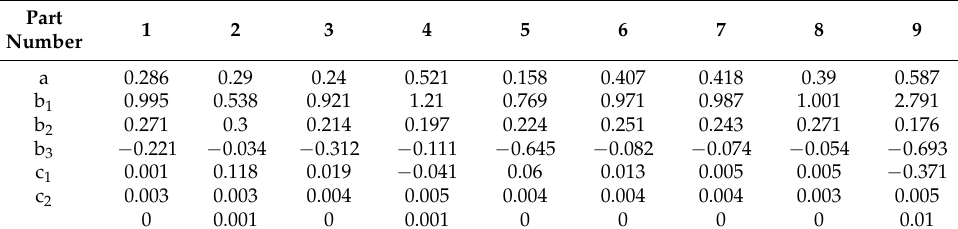
Table 2. The undetermined coefficients of the response surface function when λ = 0.5.